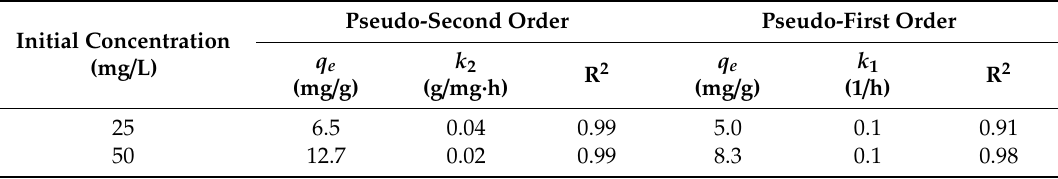
Figure 7a. The removal e ffi ciency of Cr(VI) 100 mg / L was 81.6% ± 2.3%, 90.9% ± 1.3%, 92.9% ±